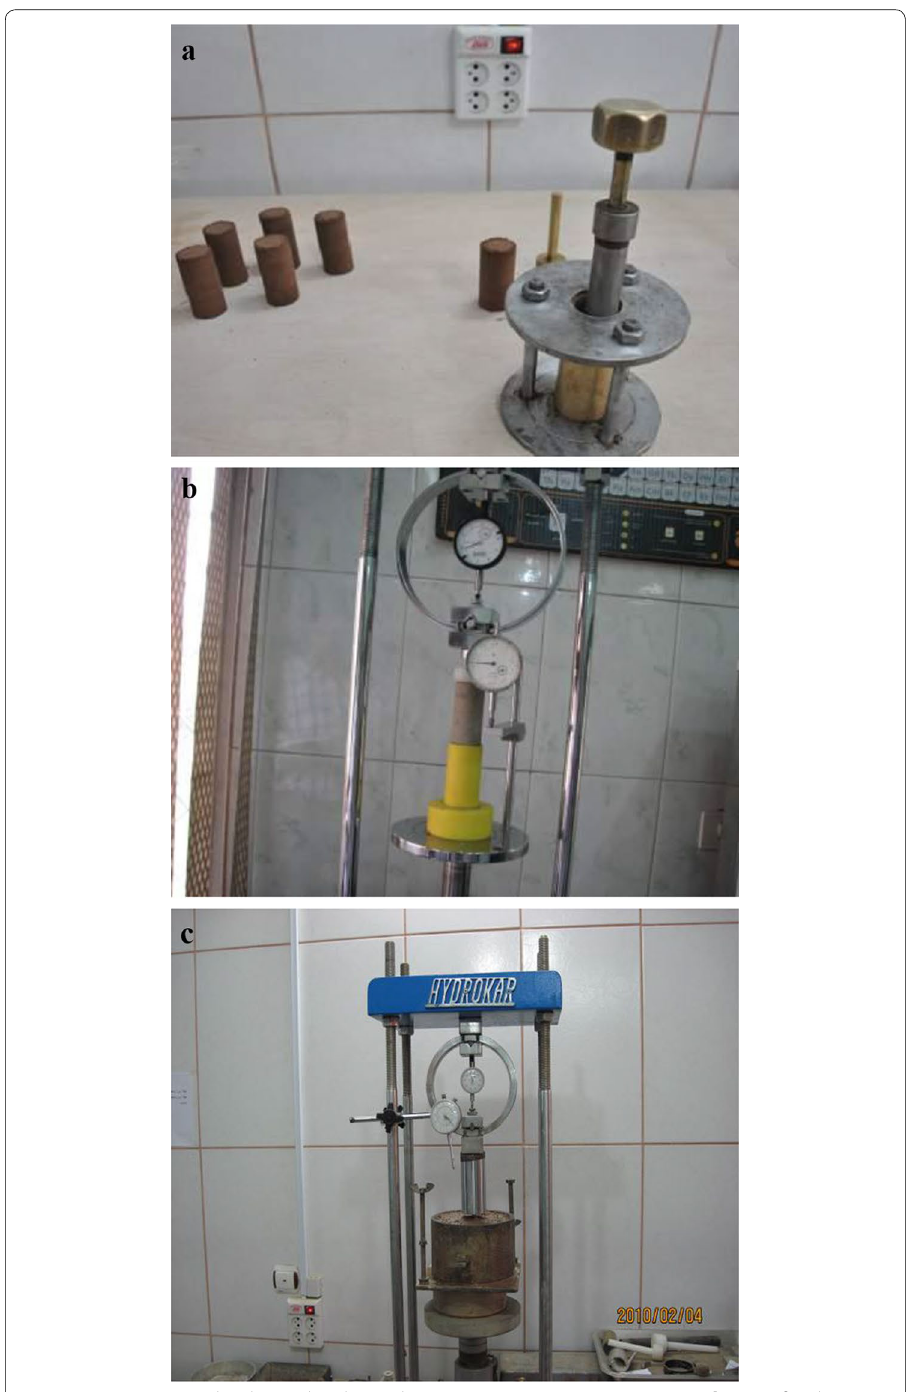
Fig. 2 Apparatuses used in this study: a harvard miniature compaction test apparatus, b unconfined com- pressive strength, c CBR test